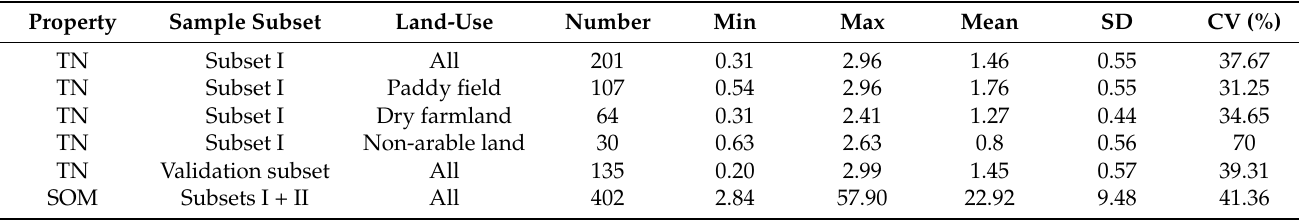
Table 1. Summary statistics a of soil total nitrogen (TN) (g kg − 1 ) and soil organic matter (SOM) (g kg − 1 ) in different sample subsets and land-use types.